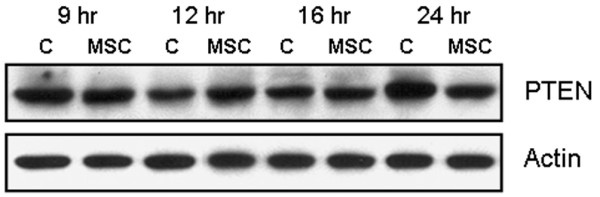
Effect of Se-methylselenocysteine (MSC) on PTEN levels in TM6 cells. Synchronized TM6 cells were treated with 50 μM MSC as described in Fig. 1. An equal amount of protein lysates (50 μg) was loaded on each lane. Immunoblots were probed with anti-PTEN and anti-actin as described in the Materials and methods section. The protein levels of PTEN in the control cells were not significantly different from that of MSC-treated cells at various time points.